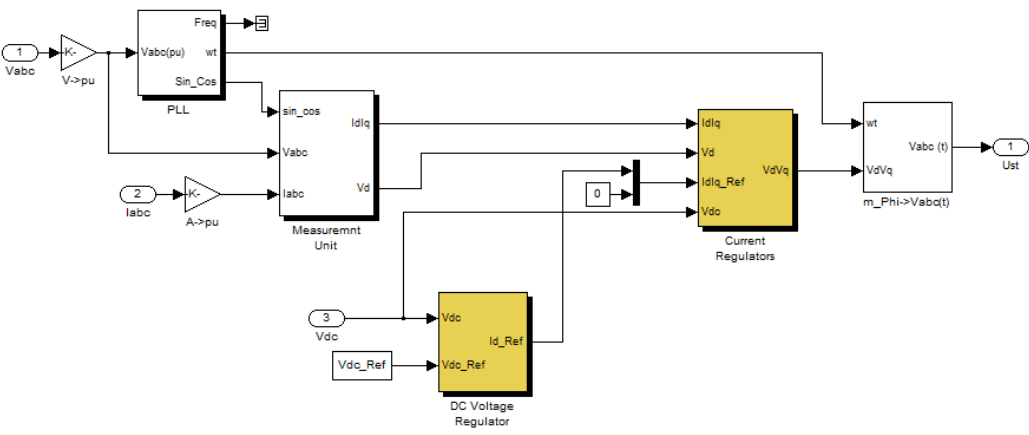
Figure 5. Block diagram of the grid side converter (GSC) controller in the Simulink model.